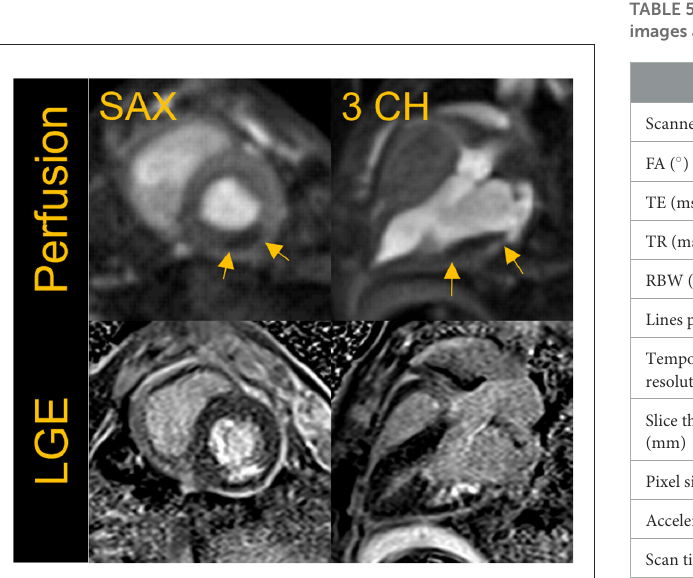
FIGURE7 First-pass perfusion images acquired at rest with a fat suppressed, saturation-recovery T1-weighted gradient echo (GRE) sequence shows rest perfusion defect in the short-axis (SAX) and three- chamber view in a porcine infarct model where the left circumflex artery was occluded. The images shown here were acquired ∼ 5 weeks post-myocardial infarction (MI). The perfusion defect visually correlates well to the region of infarct as seen in the corresponding breath-held segmented late gadolinium enhancement (LGE) images.